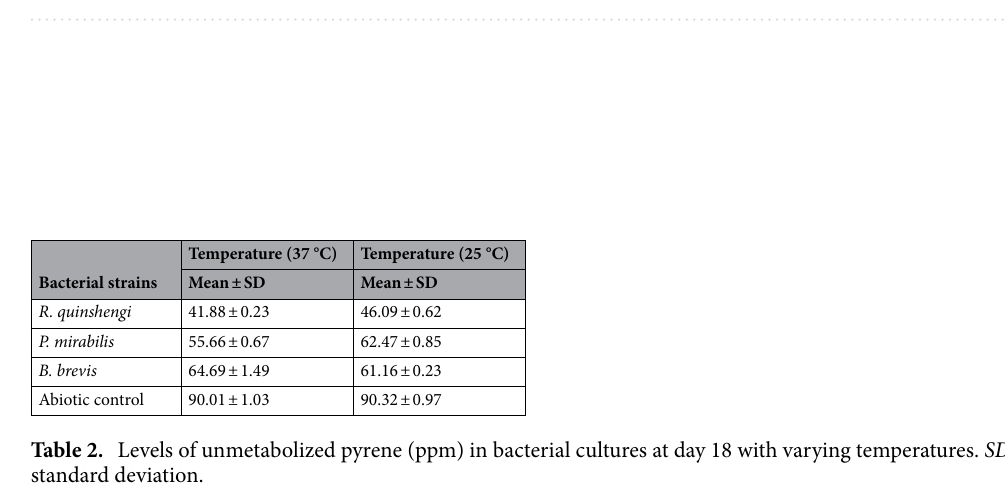
Figure 6. Pyrene degradation curves at ( c1 )37 °C and ( c2 )25 °C; Control experiments (solid sphere), B. brevis (solid squares), P. mirabilis (diamond), and R. qinshengi (triangle).